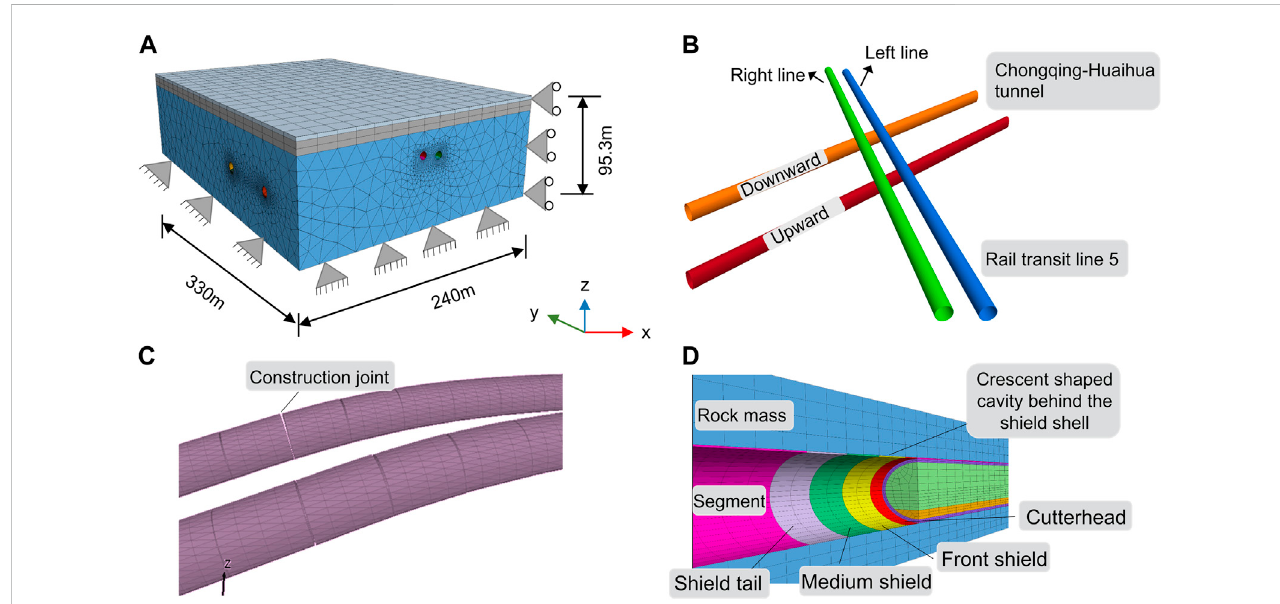
Numerical model. (A) Overall model. (B) Adjacent tunnel. (C) Lining construction joint. (D) TBM tunneling construction.